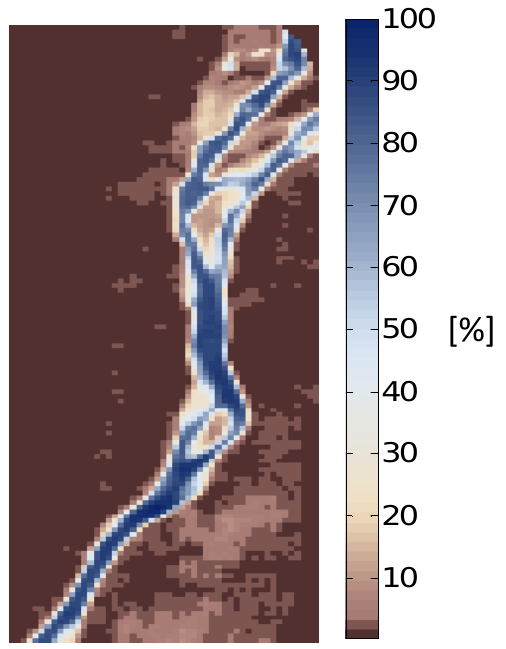
Figure 13. Frequency map of water coverage for the Lokaja section of the Niger